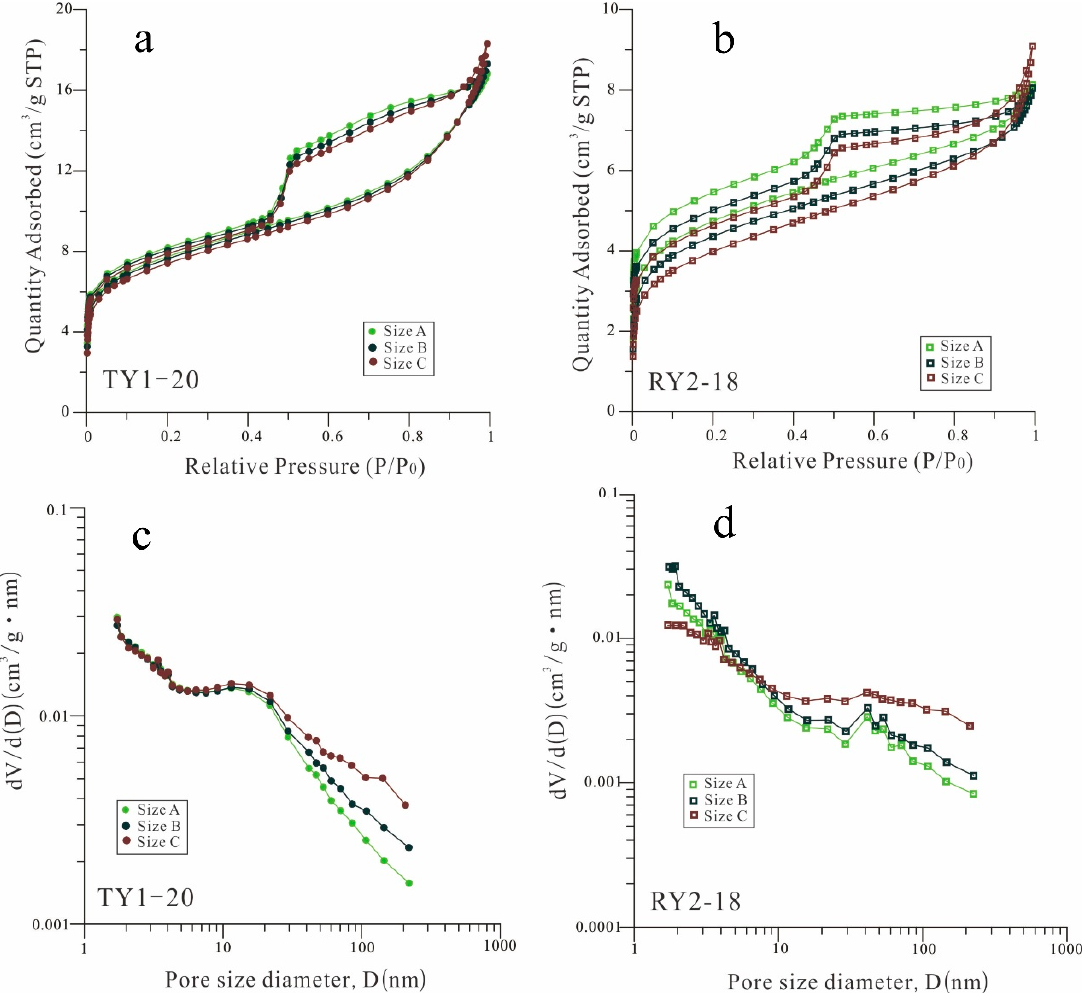
Figure 4. ( a , b ) Low-pressure N 2 adsorption/desorption isotherms and ( c , d ) PSD for the TY1-20 and RY2-18 samples with three different particle sizes.